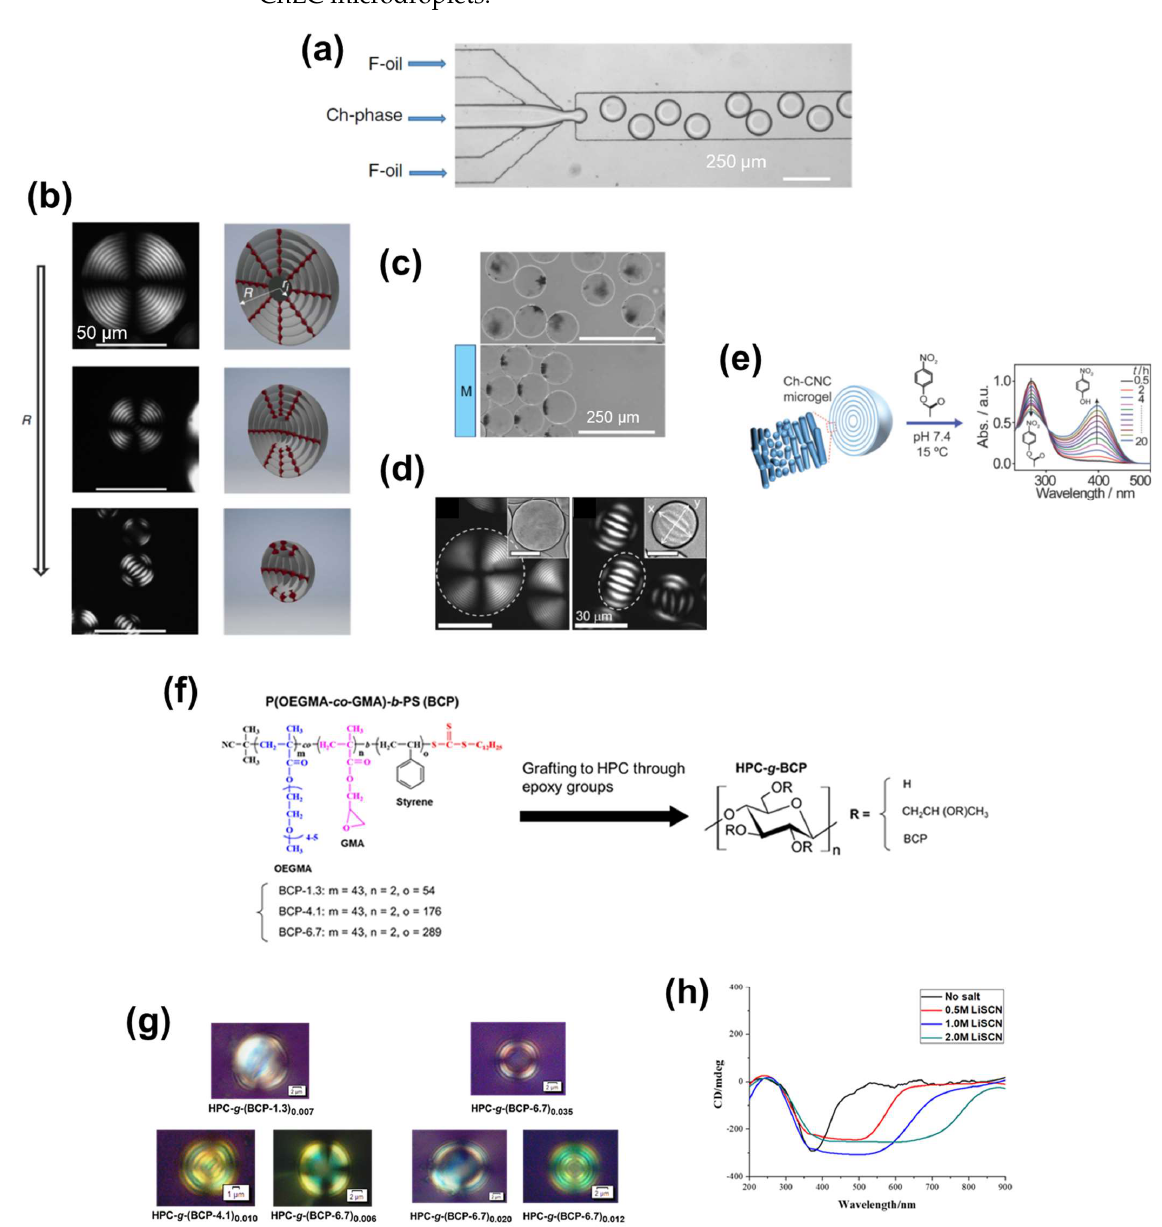
Figure 12. ( a ) Optical microscopy image of microfluidic emulsification of a cellulose nanocrystal (CNC) cholesteric liquid crystal (ChLC) aqueous dispersion in oil. ( b ) Polarized optical microscope (POM) images of CNC-based ChLC microdroplets with dimensions in the range of 40 ≤ R ≤ 115 µ m, 10 ≤ R ≤ 40 µ m, and R ≤ 10 µ m. ( c ) Optical microscopy images of CNC-based ChLC microdroplets loaded with magnetic nanoparticles with and without an applied magnetic field (( a – c ) were reproduced from [103] by permission of Nature Springer). ( d ) POM images of CNC-based ChLC microgels in water, with insets showing the corresponding bright field images. ( e ) Time dependence of the UV–Vis spectra of aqueous 4-nitrophenyl acetate mixed with CNC-based ChLC microgels (( d , e ) were reproduced from [104] by permission of Wiley). ( f ) Schematic for hydroxypropyl cellulose (HPC)- g -block copolymer (BCP) synthesis. GMA, glycidyl methacrylate; OEGMA, oligoethylene glycol methacrylate; P(OEGMA- co -GMA, poly(oligoethylene glycol methacrylate- co -glycidyl methacrylate); PS, polystyrene. ( g ) POM images of ChLC microdroplets formed by HPC- g -BCPs with various PS block lengths and comparable DS BCP (left three images), and with different DS BCP and comparable PS block lengths (right three images). ( h ) Circular dichroism spectra of the ChLC emulsions formed by HPC- g -(BCP-6.7) 0.006 with various concentrations of LiSCN (( f – h ) were adapted with permission from [106], copyright (2021) American Chemical